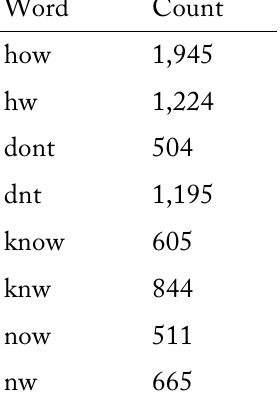
Table 5: Common words with <O>s and their alternate spellings